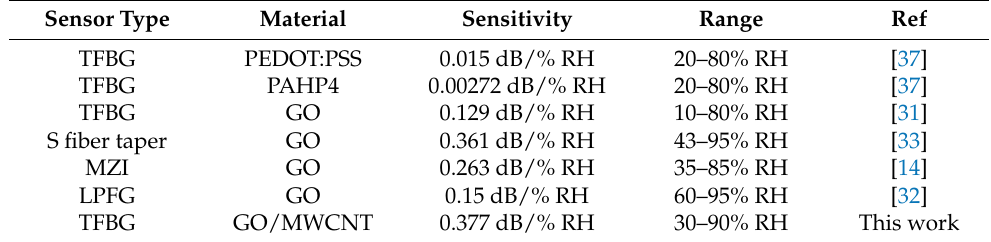
Figure 6. Stability and the response time of the TFBG humidity sensor coated functional GO/MWCNTs hybrid nano- material. ( a ) Stability test in a constant temperature and humidity chamber (25 ◦ C temperature, 30% and 70% RH, 60 min) ( b ) Dynamic response times (the RH changes from 90% to 40%). Table 1. Comparisons of fiber RH